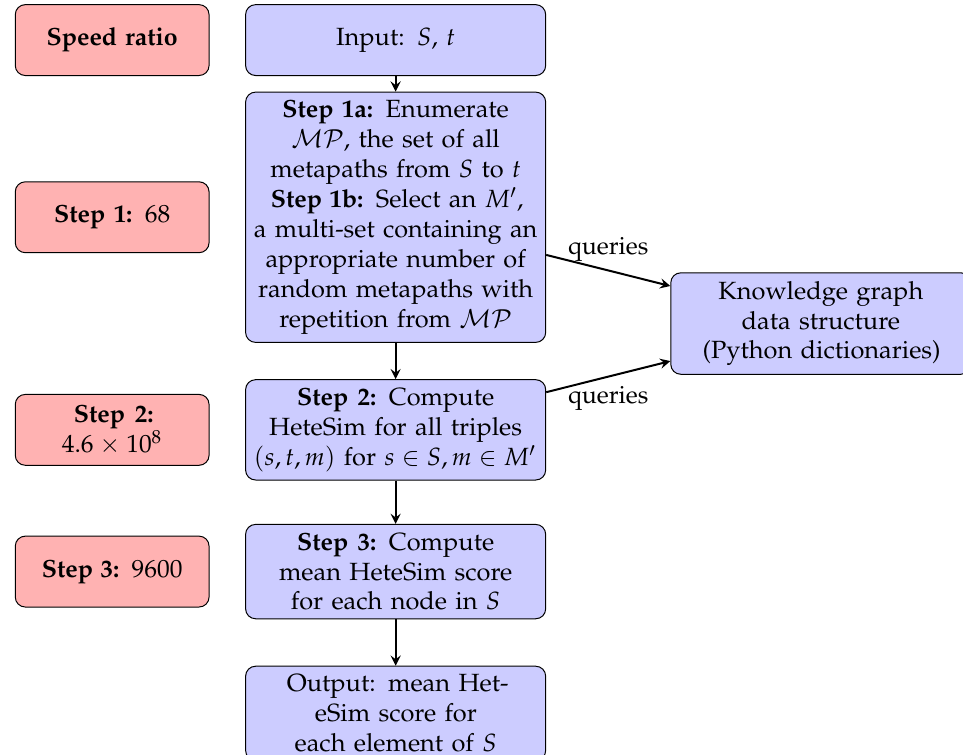
Figure 5. Overview of SemNet version 2 approximate mean HeteSim implementation. Speed ratio is ( SemNet 1 time ) / ( SemNet 2 time ) and is given for source node insulin and target node Alzheimer’s disease. SemNet version 2 used approximation parameters (cid:101) = 0.1 and r =